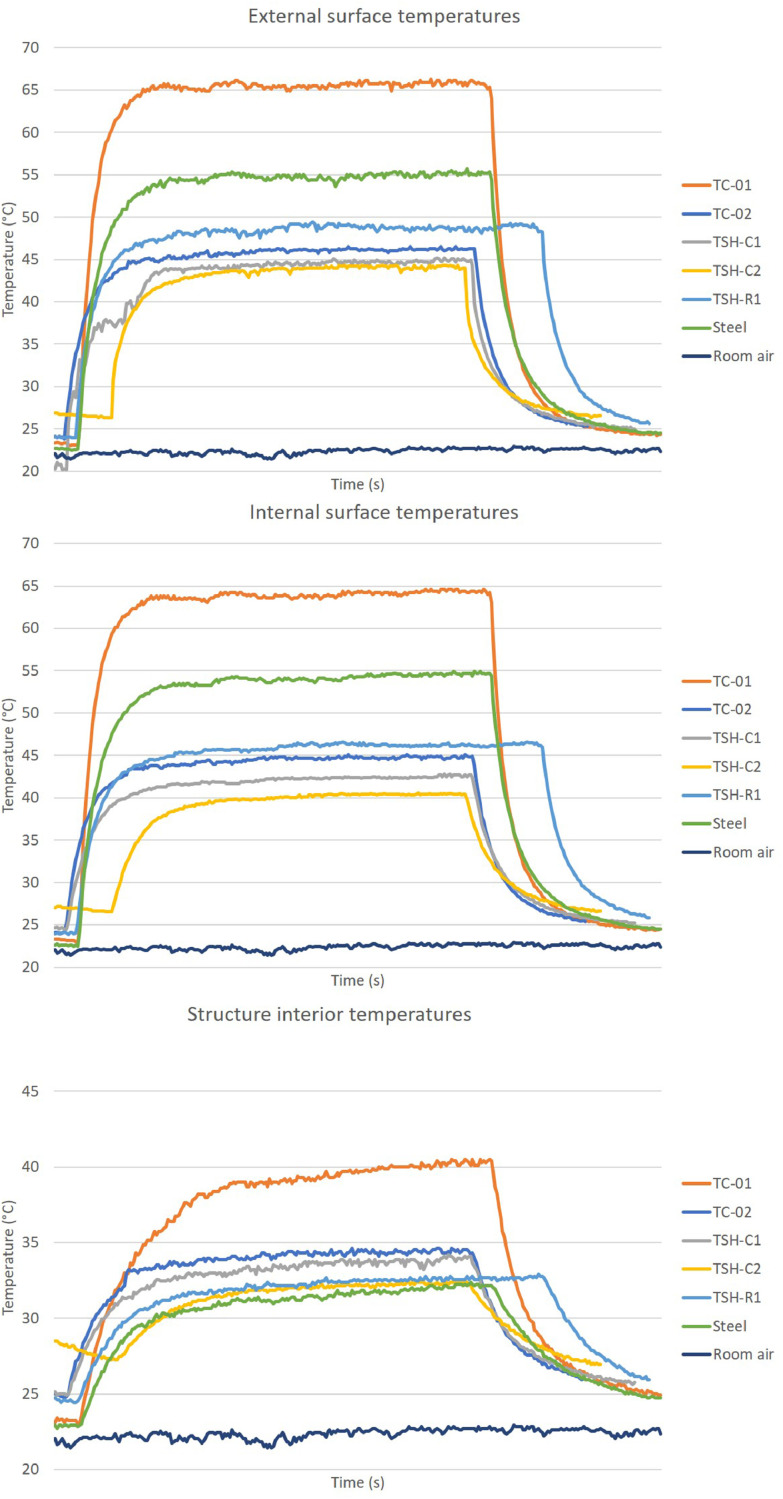
40 cm/no airflow.